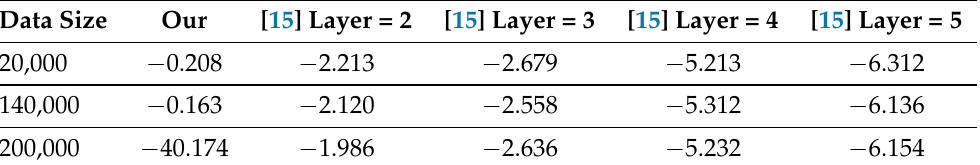
Table 3. Comparisons of the average difference of IMP between our model and the different models in [15].